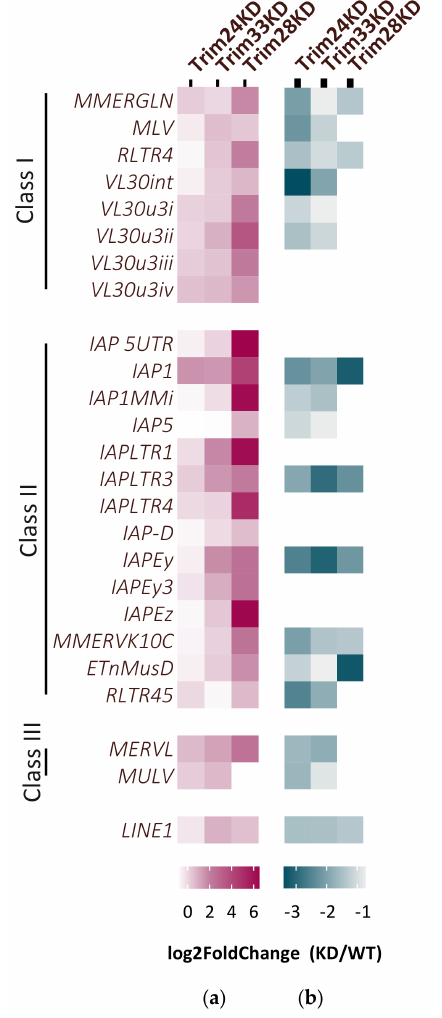
Figure 3. Tif1 family members contribute to the silencing of distinct ERVs subfamilies. ( a ) ERV expression change of KD vs. WT was measured using RT-qPCR. The three KD are ESCs expressing shRNA targeting either Trim24, Trim33 or Trim28 ( n > 3). ( b ) H3K9me3 enrichment on ERVs was measured by chromatin immunoprecipitation (ChIP). Normalized log2 fold change of KD vs. WT is presented ( n = 2) Statistical significance determined using the Holm-Sidak method, with alpha = 0.05, see also Figure